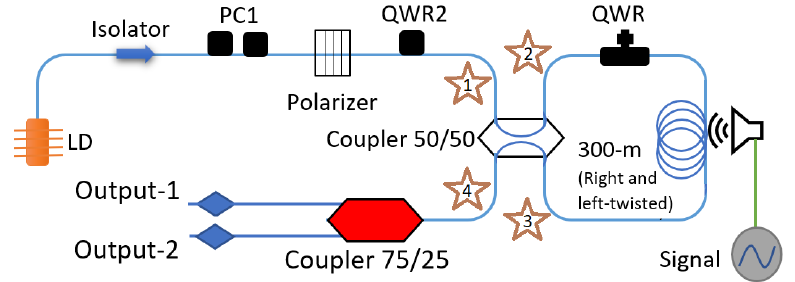
Figure 1. Schematic diagram of the OFSI.